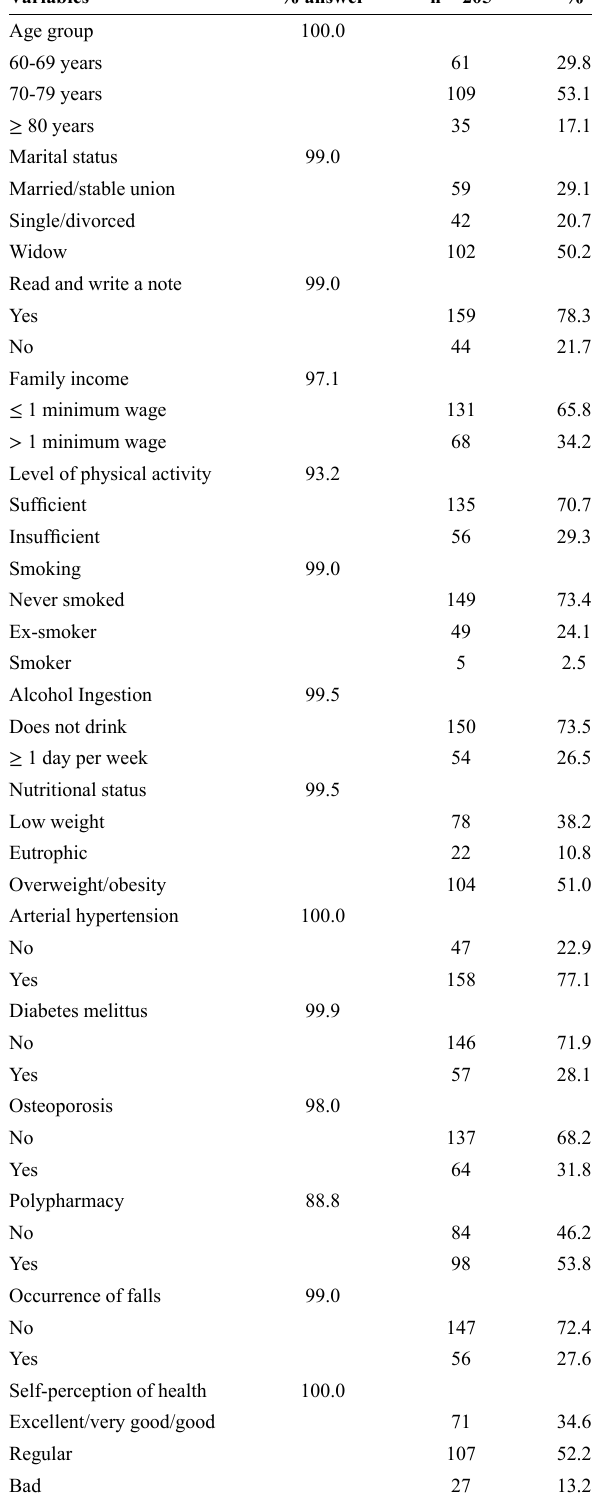
Table 1 - Descriptive analysis of socio-demographic, behavioral, and health condition characteristics of the 205 older women participating in the study. Jequié-BA, Brazil, 2017.